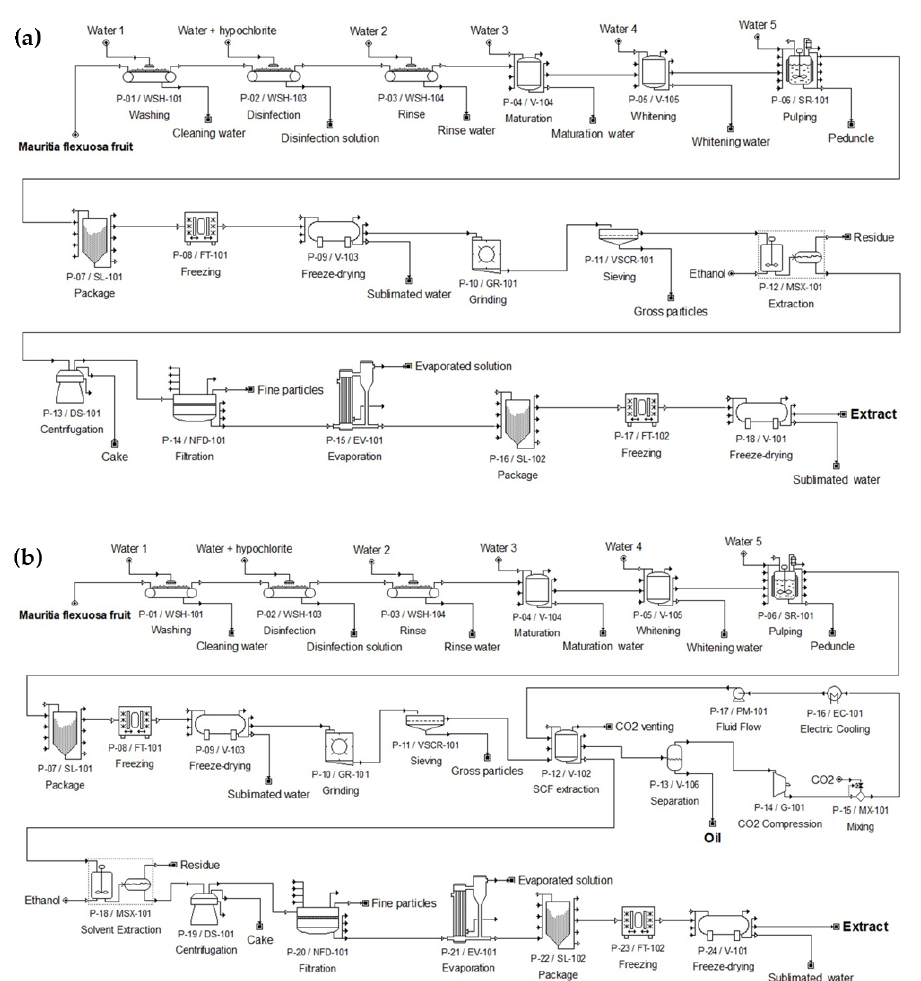
Figure 1. Flowsheet of the ( a ) single-stage process by conventional solvent extraction (CSE) and ( b ) sequential two-stage process using supercritical and conventional solvent extraction (SFE+CSE), designed by the SuperPro Designer 9.0 software.